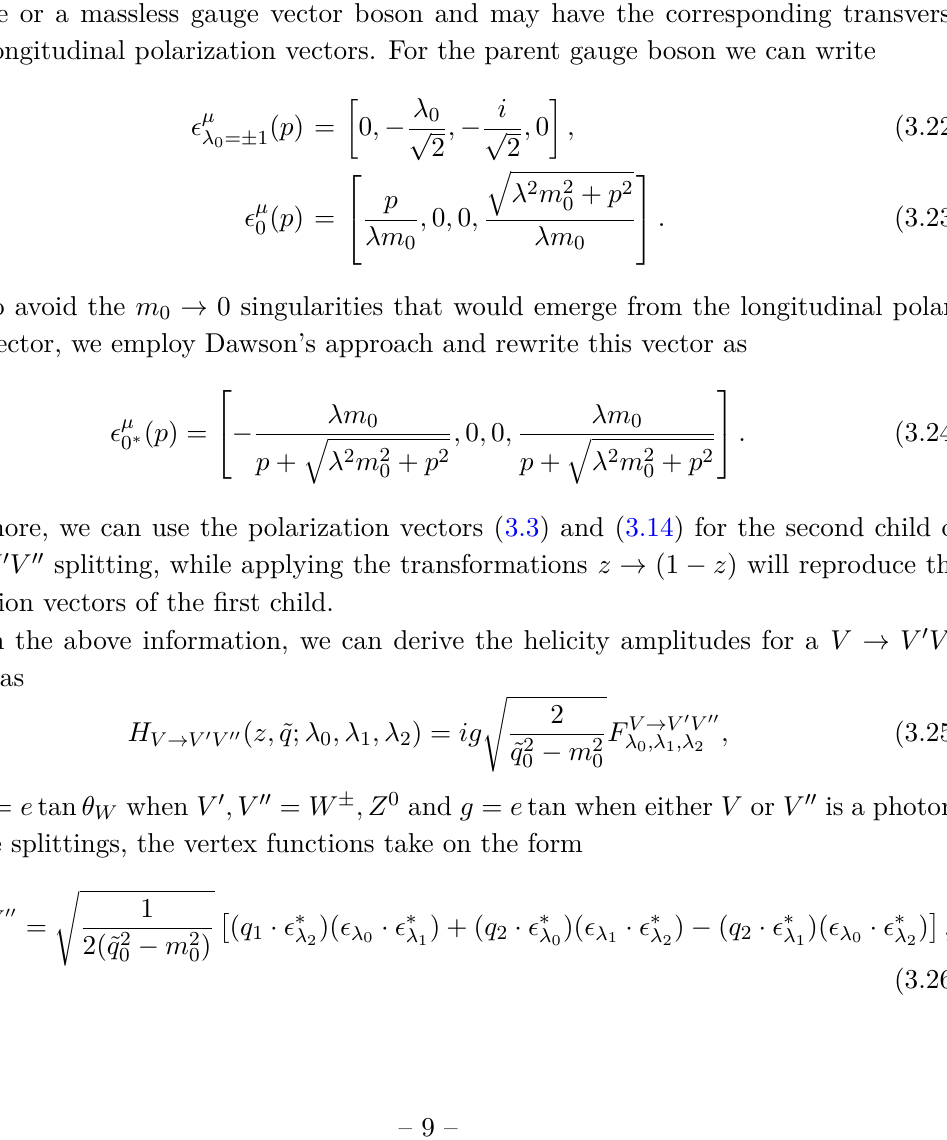
represent the helicity states of the 2